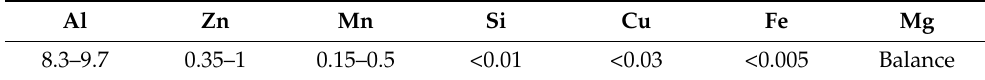
Table 1. Chemical composition of base material (wt%).